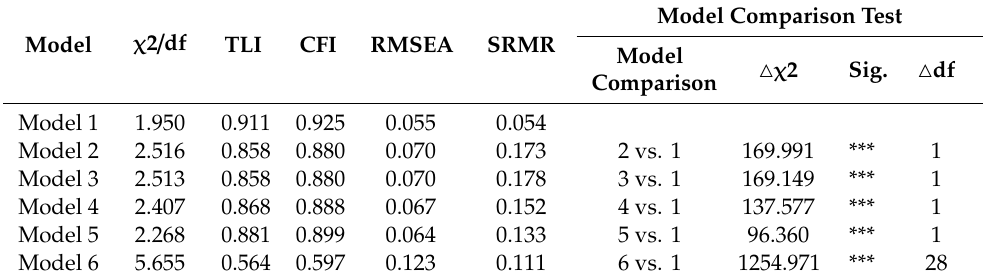
Table 3. Multi-model confirmatory factor analysis (CFA) comparison